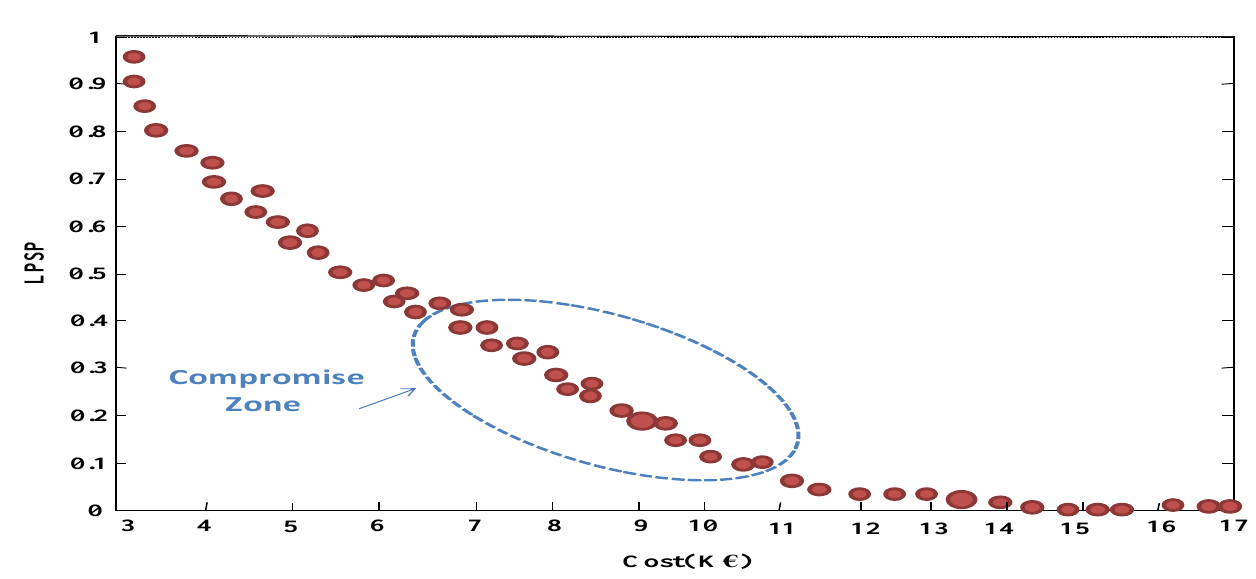
Figure 15. Pareto front of optimal system configurations.